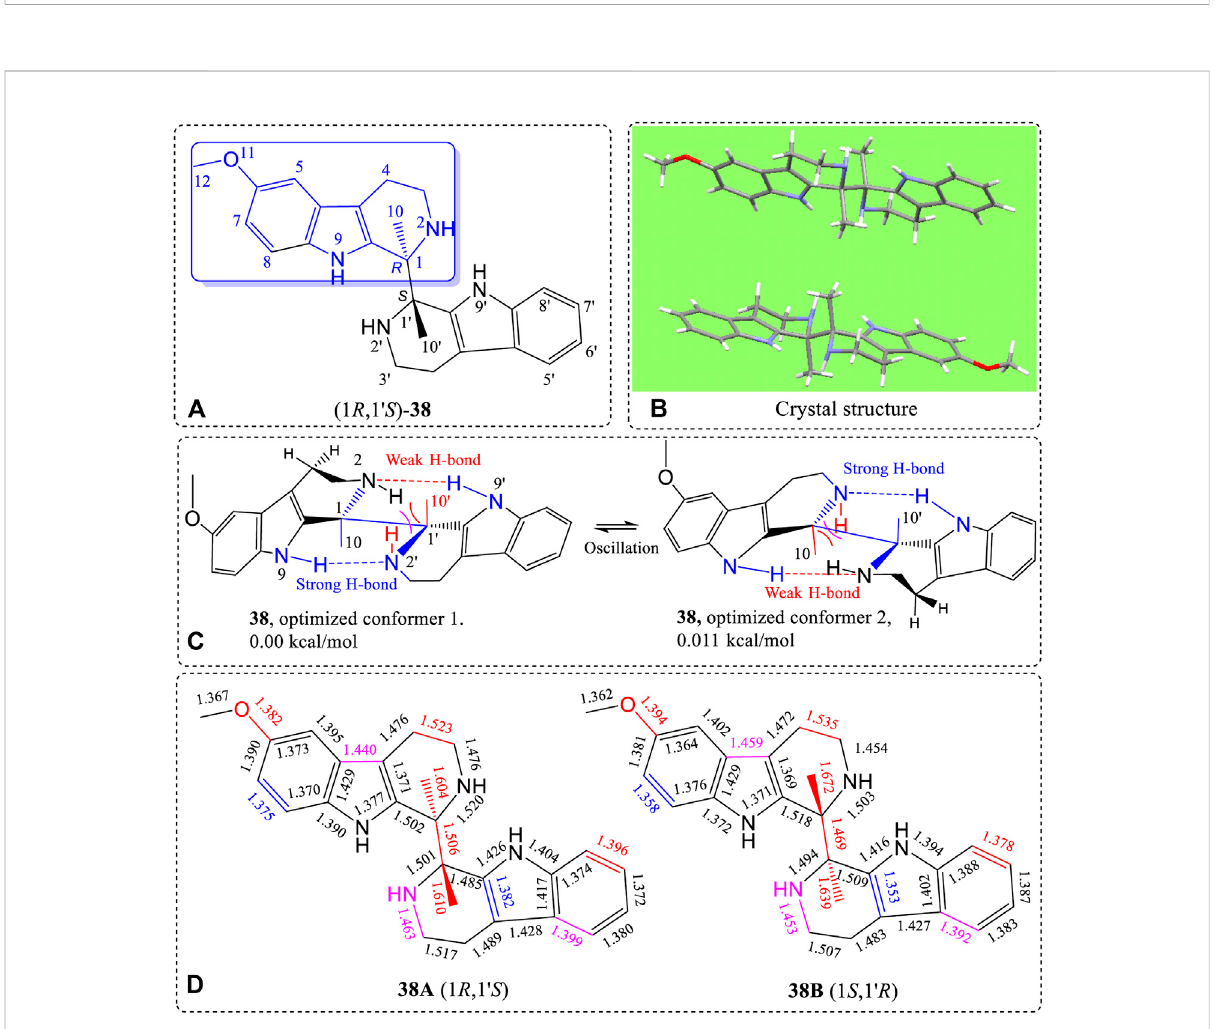
FIGURE 16 (A) Structure of 38 , (B) X-ray structure, (C) B3LYP/6-311+G(d)-optimized geometries with the lowest and second lowest energy structures shown, and (D) differences of bond lengths of the corresponding bonds of the (1 R ,1 ′ S )- 38A and (1 S ,1 ′ R )- 38B enantiomer from the X-ray structure of the crystalline